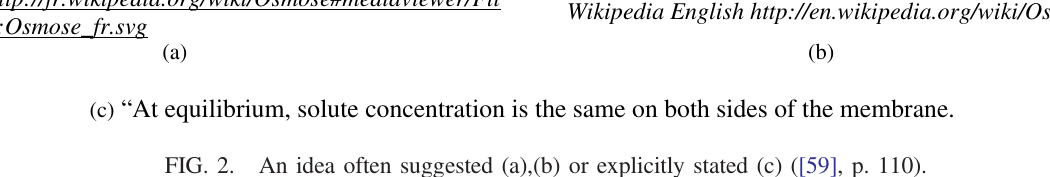
FIG. 2. An idea often suggested (a),(b) or explicitly stated (c) ([59], p.